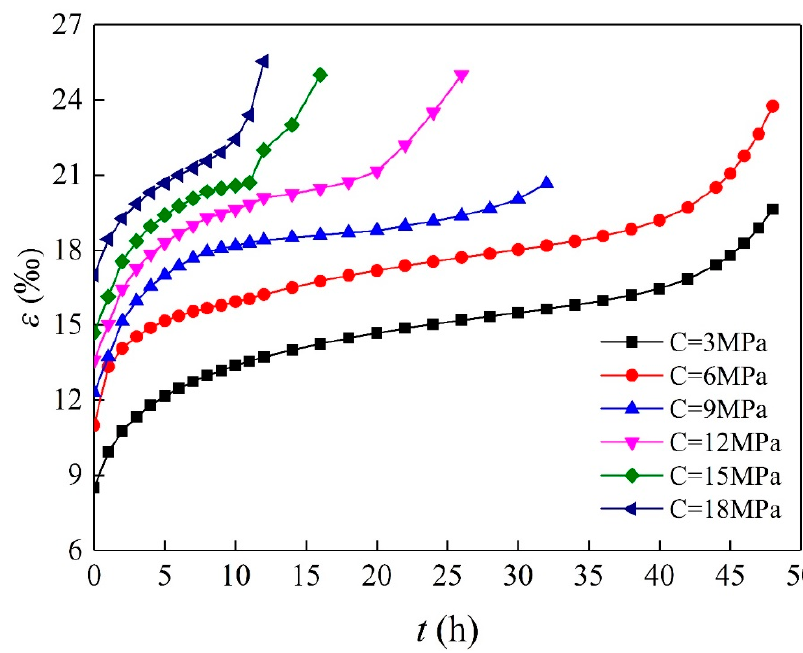
Figure 3. Strain-time curves and strain-time curves for each stage of AS samples under various confining pressures: ( a ) 3 MPa, ( b ) 6 MPa, ( c ) 9 MPa, ( d ) 12 MPa, ( e ) 15 MPa, and ( f ) 18 MPa.